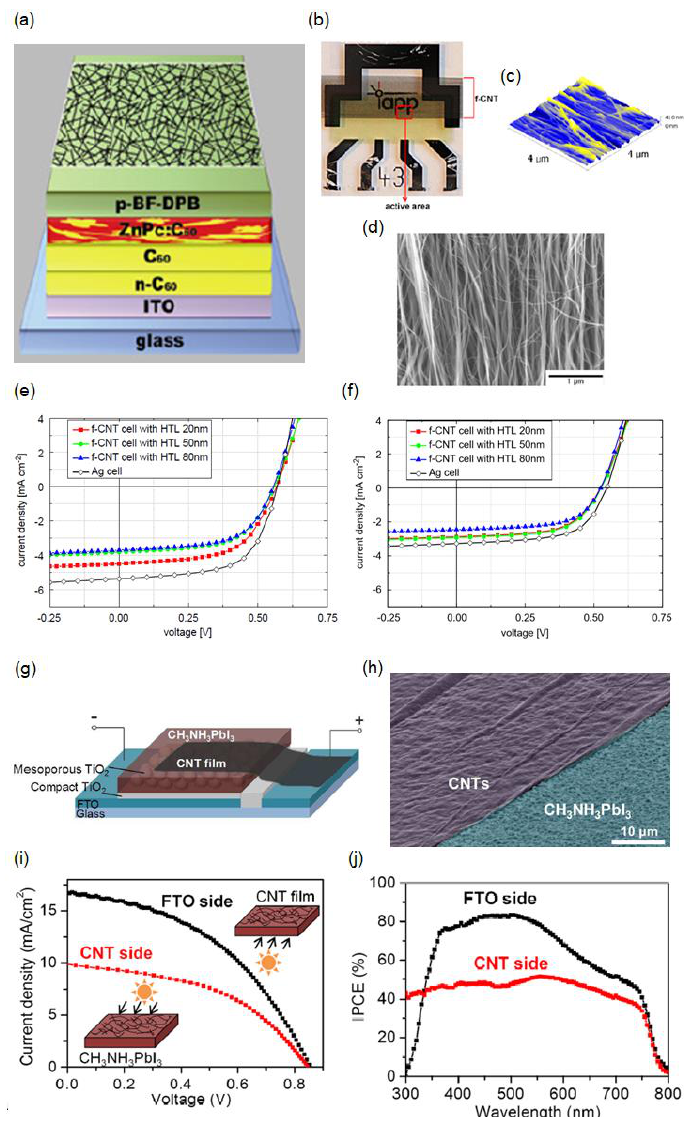
Figure 6. ( a ) Schematic of the SSC with the transparent freestanding multi-wall carbon nanotube (f-CNT) top electrode; ( b ) Photograph of the f-CNT cell; ( c ) AFM image (4 μm × 4 μm); ( d ) SEM image